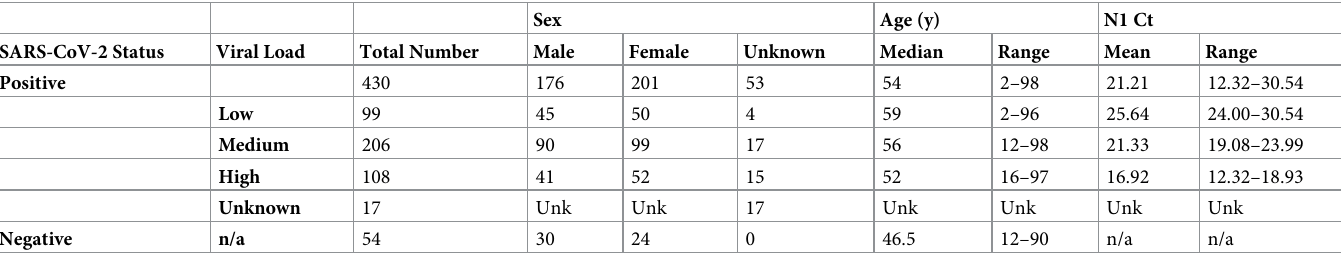
Table 1. Patient demographics of SARS-CoV-2 positive and negative